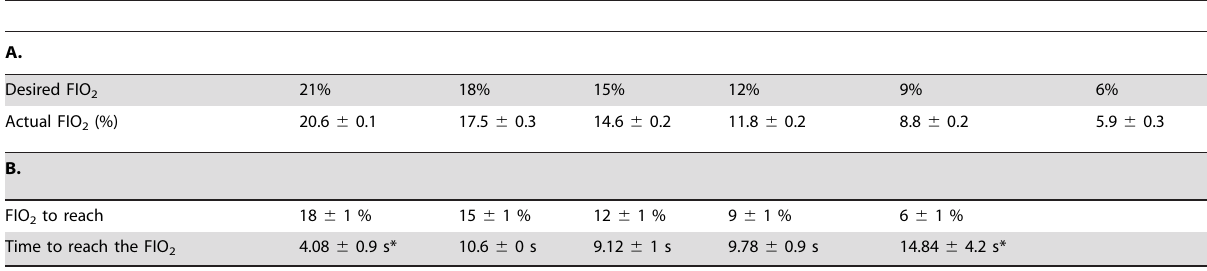
A) Evaluation of actual inspiratory fraction of oxygen (FIO 2 ) for the different FIO 2 values tested. Values are expressed as mean 6 SD. B) Time necessary to reach a stable composition ( 6 1%) for the different FIO 2 values tested. ANOVA on ranks was used as the statistical test. Values are expressed as mean 6 SD. p values were , 0.05; *Indicates significant difference (p , 0.001) between the time to reach 18 6 1 % and 6 6